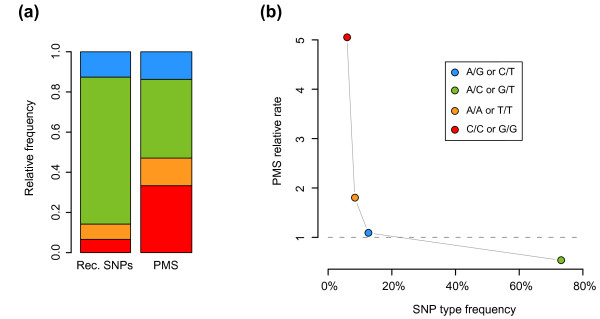
Post-meiotic segregation occurs preferentially at specific polymorphism types. (a) Relative frequencies of the possible mismatches given the SNPs found in PMS events and in recombination events (Rec. SNPs). (b) Inverse relationship between the frequency of the different SNP types in the S. cerevisiae species and the efficiency with which the mismatches generated by the SNPs are repaired (PMS relative rate = PMS frequency/Recombination SNP frequency). In the figure the frequencies of SNPs between S288c and YJM789 are shown. The result is qualitatively the same when calculating SNP frequencies with other strains [37].